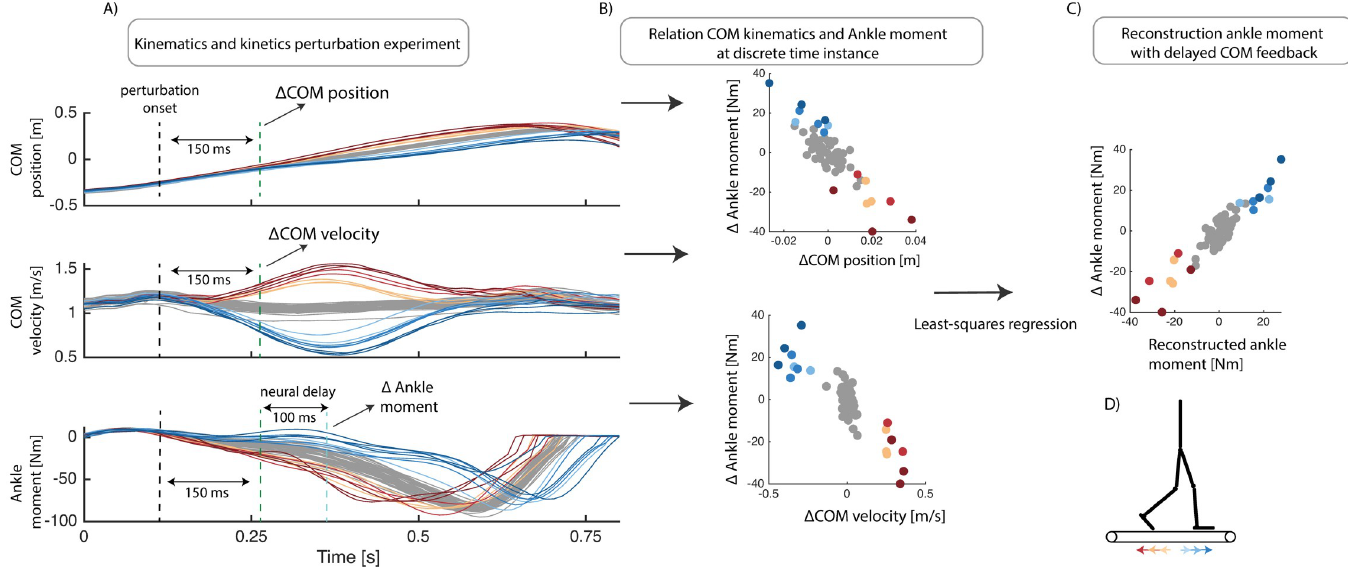
Fig 2. Least-squares regression to evaluate the relation between delayed feedback of COM kinematics and ankle joint moment in reponse to belt-speed perturbations during walking (Data from [10]). Deviations in COM position and velocity from unperturbed trajectory (gray), 150 ms after a belt speed perturbation, were used as input in a least-squares regression model. The deviation in ankle moment from the unperturbed trajectory, with an additional 100ms neural delay, was used as output in the regression model(B). The uncentered coefficients of determination ( R 2 ) and Root Mean Square Errors (RMSE) of the measured and reconstructed joint moments are reported to quantify the fit of the linear models